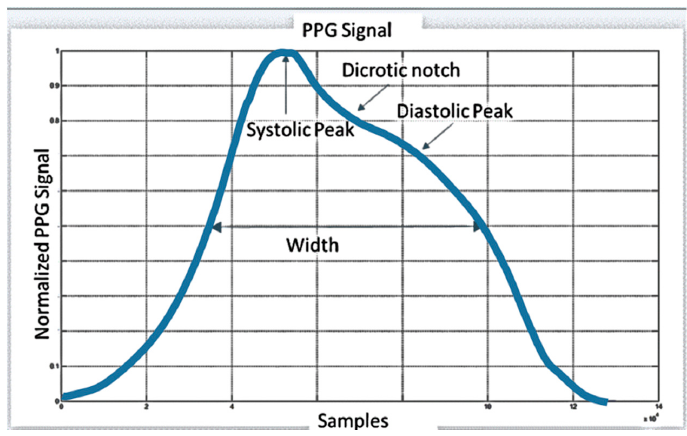
Figure 1. Compliant standard PPG waveform.